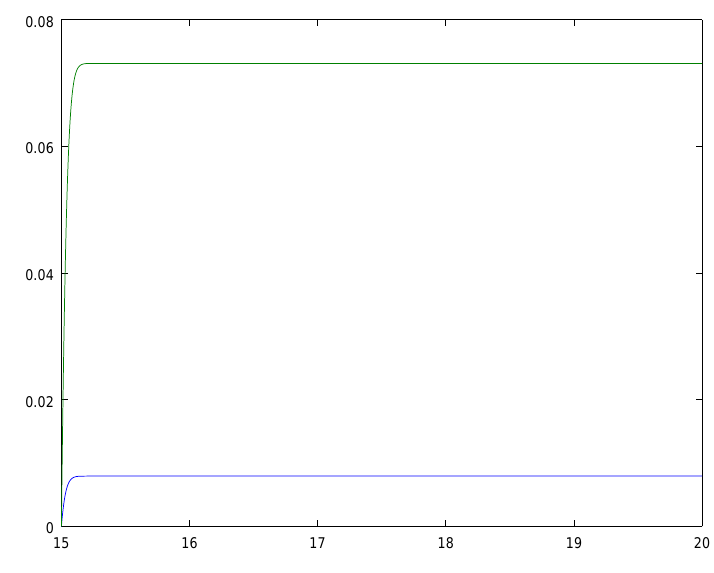
( t ) (blue). 0 (cid:48)